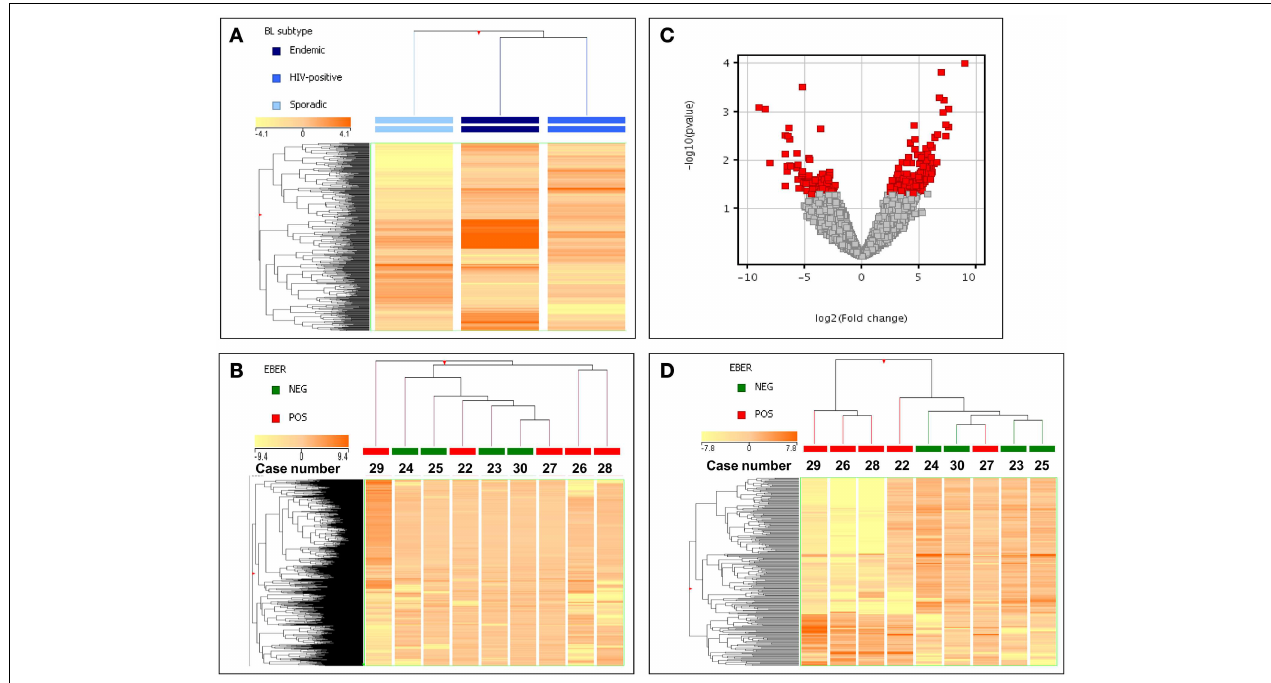
FIGURE 1 | Gene expression profiling of EBV-pos and EBV-neg ID-BL cases. (A) An ANOVA analysis demonstrated that BL subtypes are slightly different, with ID-BL being closer to eBL. In the matrix, each column represents a group (mean values recorded in each of the three groups being plotted), and each row represents a gene. The color scale bar shows the relative gene expression changes normalized to the standard deviation (0 is the mean expression level of a given gene). (B) Unsupervised hierarchical clustering failed to clearly separate EBV-positive and EBV-negative ID-BL specimens. In the matrix, each column represents a sample, and each row represents a gene. The color scale bar shows the relative gene expression changes normalized to the